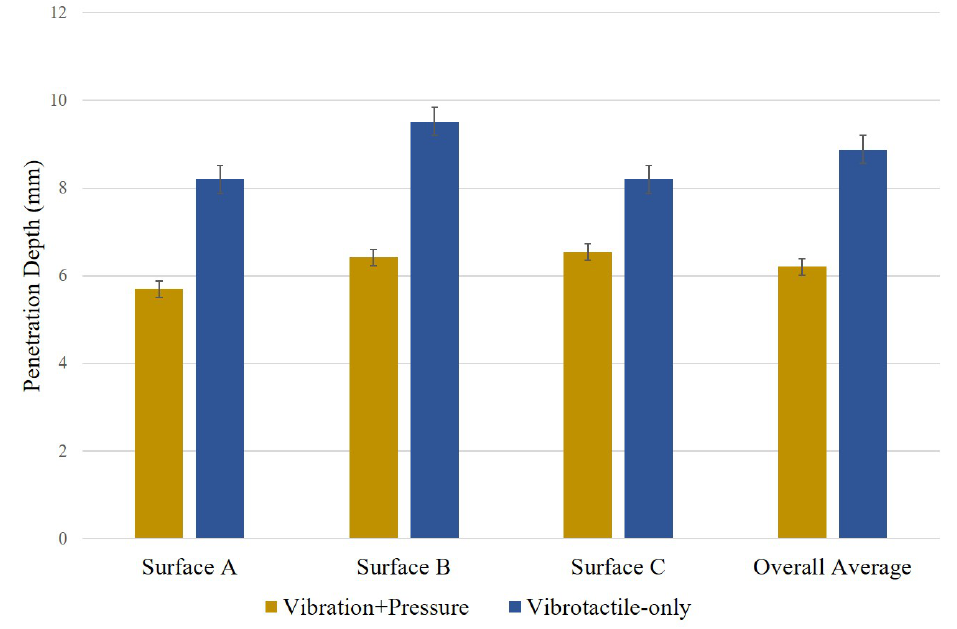
Figure 12. Mean of maximum penetration depth. The error bars show the standard